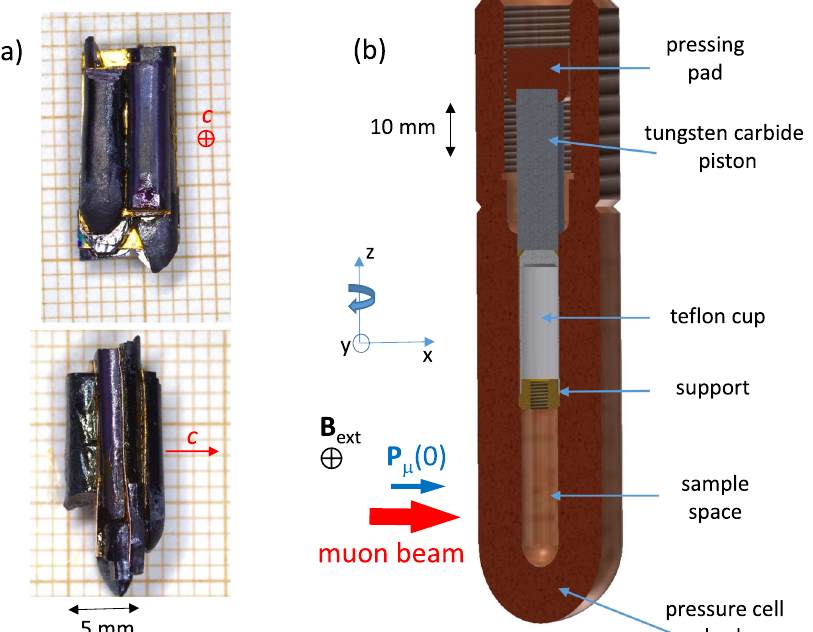
Fig. 1 Setup for hydrostatic pressure experiments. a Sr 2 RuO 4 sample, consisting of semi-cylindrical pieces glued on oxygen-free copper foils. The top and the bottom panels are the front and the side view, respectively. The crossed circle and the arrow indicate the orientation of the c -axis. b Construction of the pressure cell 34 . The sample and the pressure medium are surrounded only by beryllium-copper (the pressure cell body and the te fl on cap support). The parts of the cell with strong μ SR response (te fl on cap and tungsten carbide piston) are far from the sample and outside of the muon beam. The initial muon spin polarisation P μ (0) and the external fi eld B ext in TF- μ SR measurements are aligned along the x - and y -axes, respectively. By rotating the cell about the z - axis, the angle between P μ (0) and the sample c -axis can be